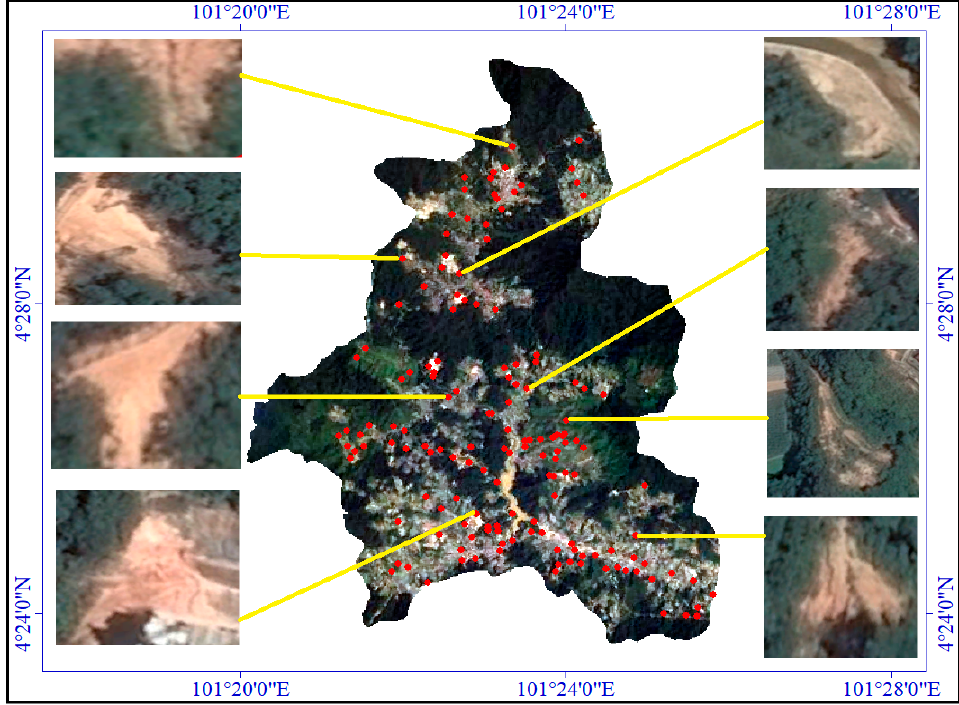
Figure 7. Landslides identified using Google Earth imagery.